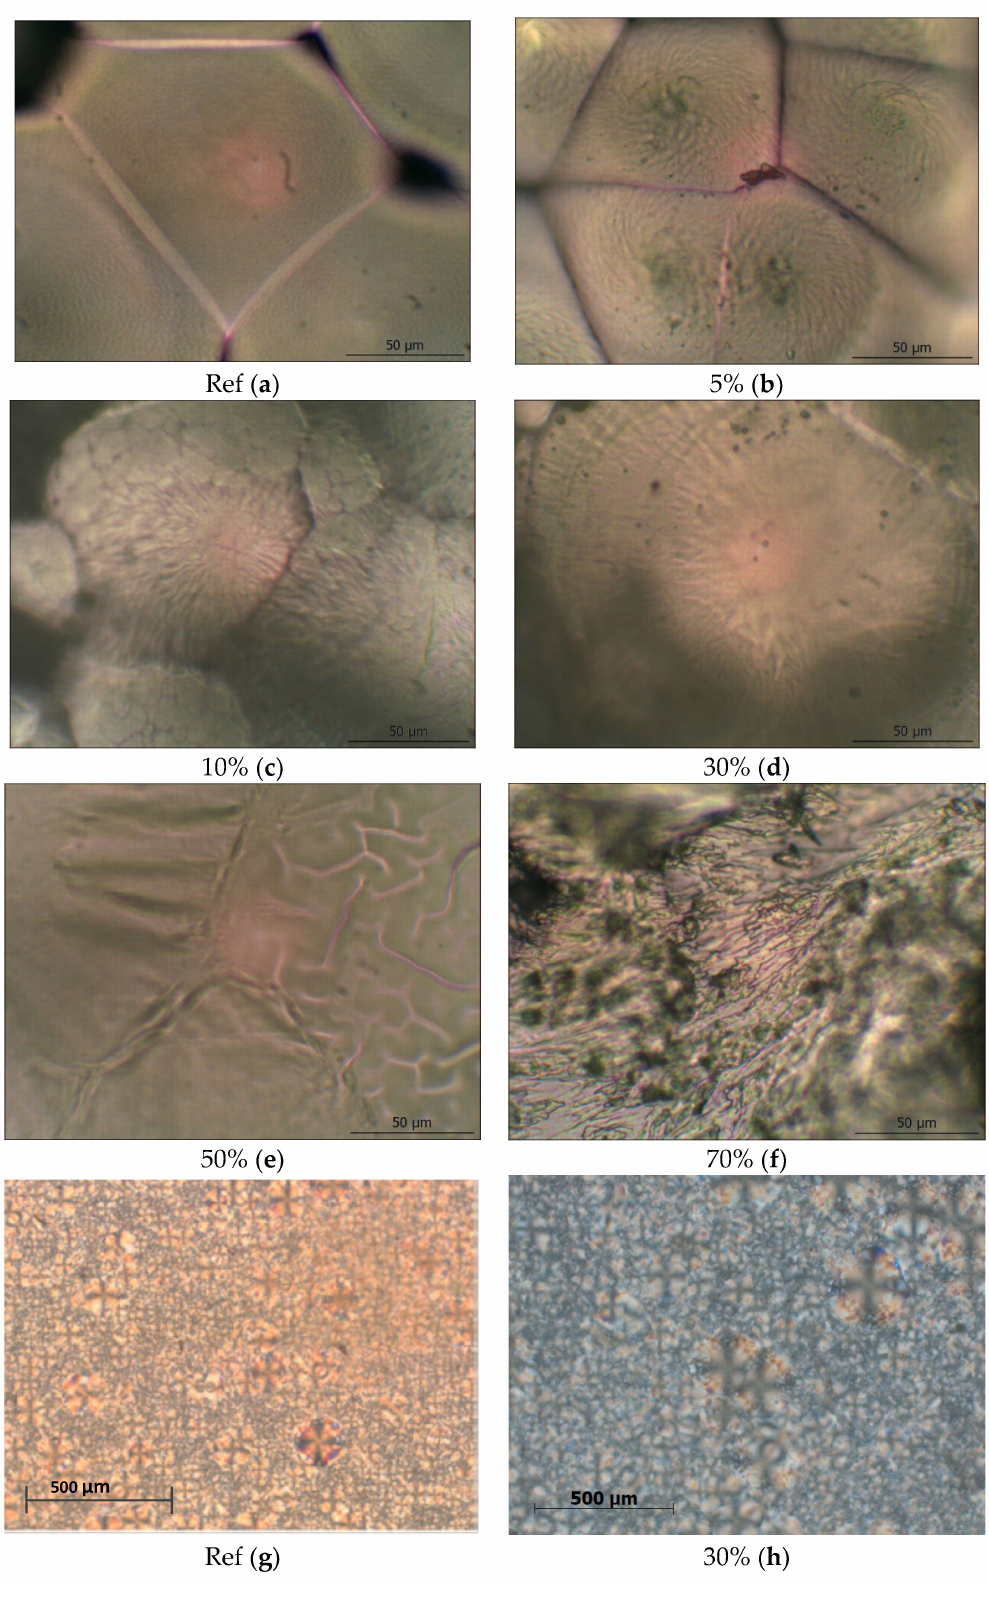
Figure 2. Microphotographs of the pristine PLA film and PLA + OTOA films obtained with an optical microscope ( a – f ) and photographs of the PLA film ( g ) and PLA +30% OTOA film ( h ) obtained with a polarizing